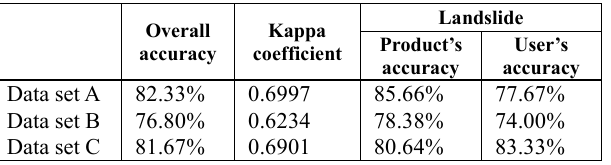
Table 3. The accuracy analysis of initial landslide